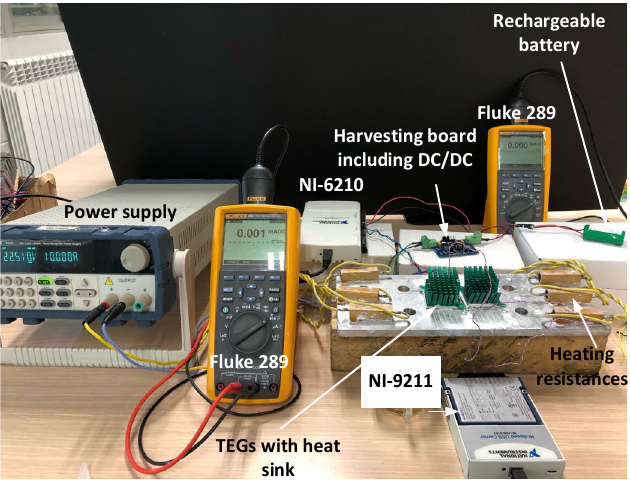
Figure 3. Experimental setup to compare the performance of TEGs and DC/DC converters.